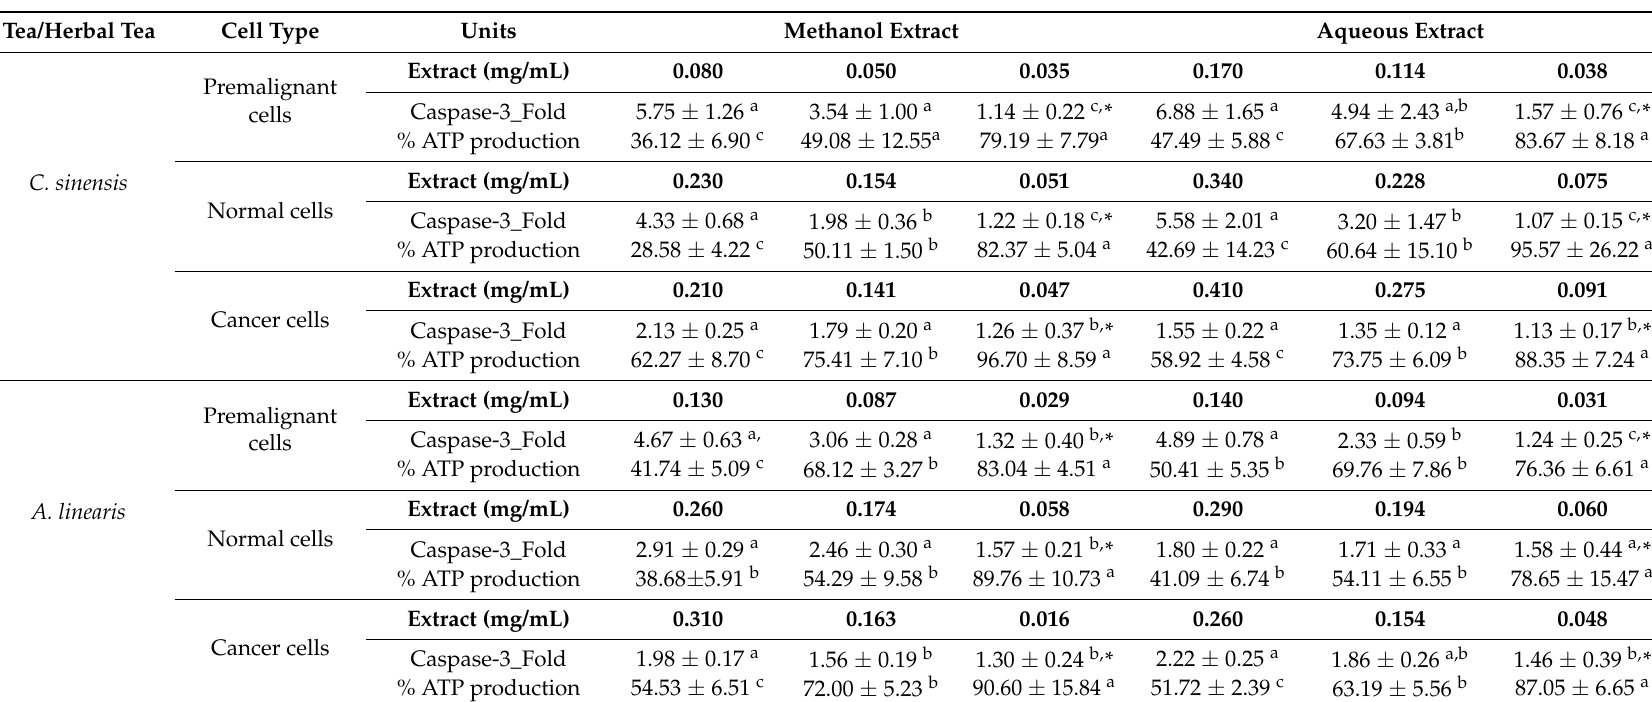
Table 2. Dose response effects of methanol and aqueous extracts of green tea and rooibos on the pro-apoptotic activity as a function of cell viability (ATP production) in skin